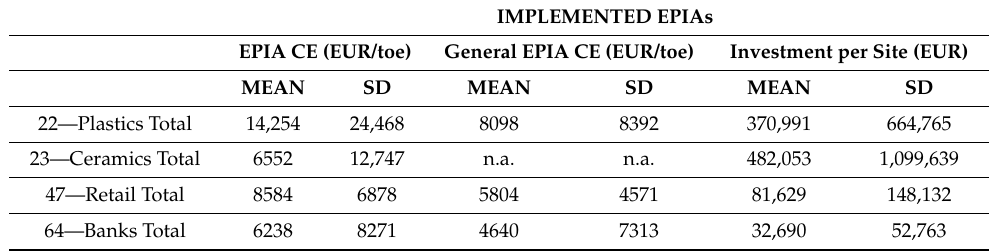
Table A3. Analysis of mean and standard deviation of CE and investments for implemented